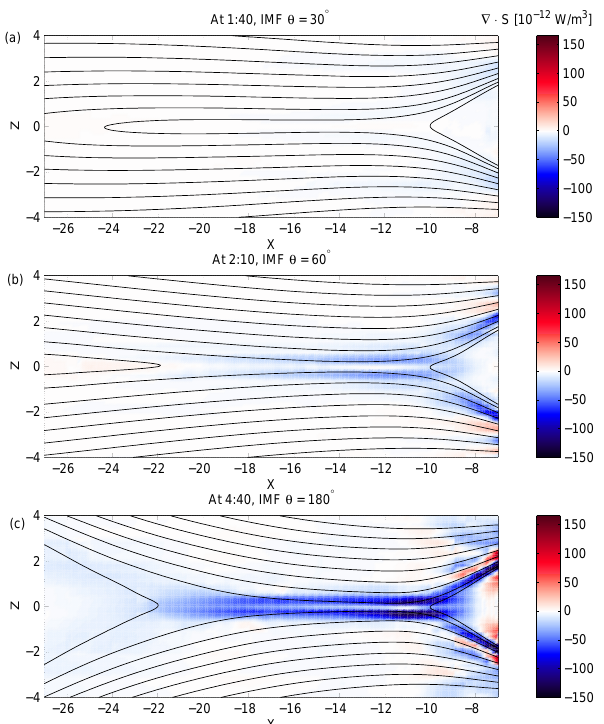
Fig. 5. The magnetotail reconnection region depicted on an XZ plane. Black lines represent magnetic field and colouring shows the Poynting divergence ∇· S . In blue areas electromagnetic energy is transformed into mechanical energy. (a) Reconnection has not yet started. (b) Weak and (c) strong